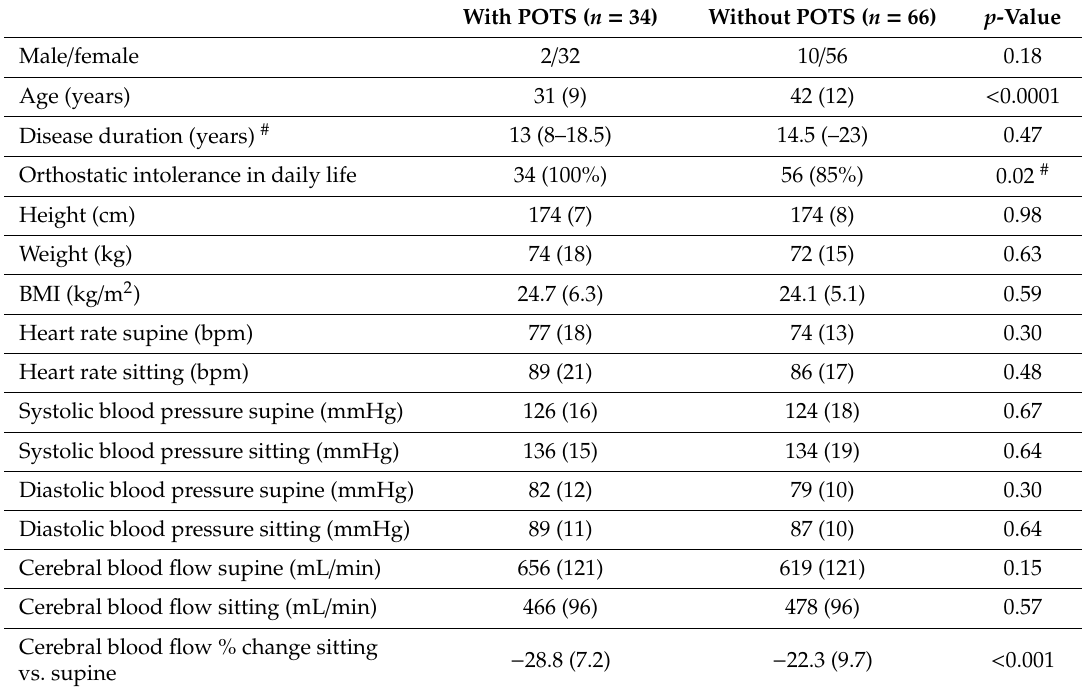
Table 4. Demographic and orthostatic stress test results in severe ME / CFS patients with and without a history of